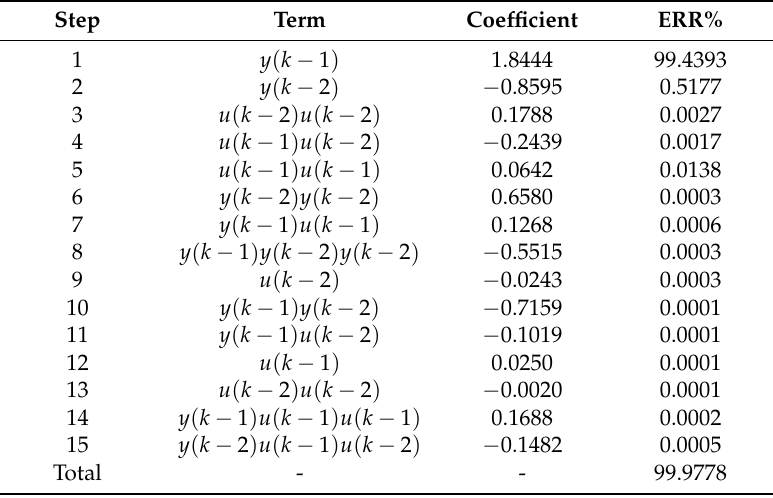
Table 3. Identification result of the test.